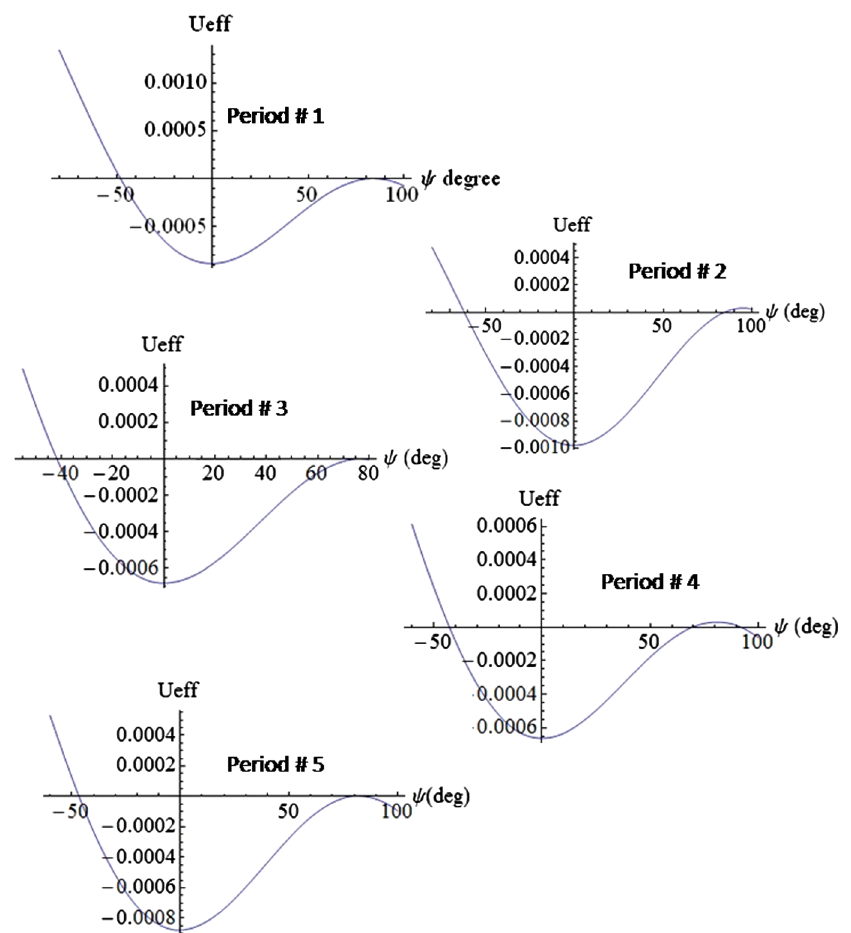
FIG. 6. Effective potential as a function of phase for all focusing periods using smooth approximation with